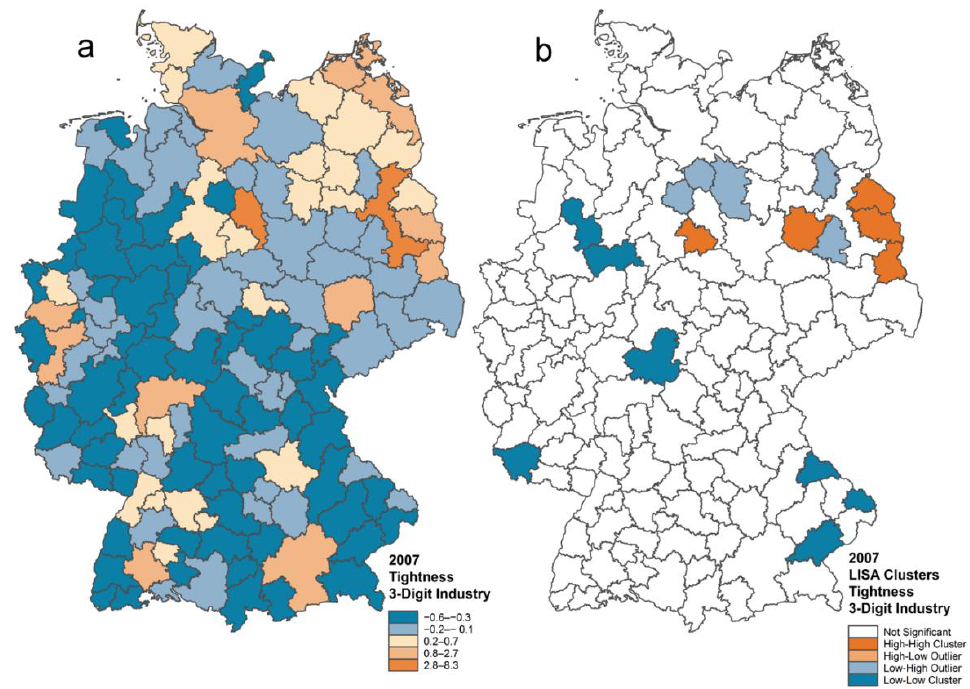
Figure 3. Spatial distribution and autocorrelation of LMR tightness values, 2007. ( a ) Tightness and ( b ) Anselin’s local Moran’s I (LISA) shown here were calculated at the 3-digit industry code level. Clusters shown in ( b ) are significant at a confidence level of 0.05 using k -nearest neighbors = 4.